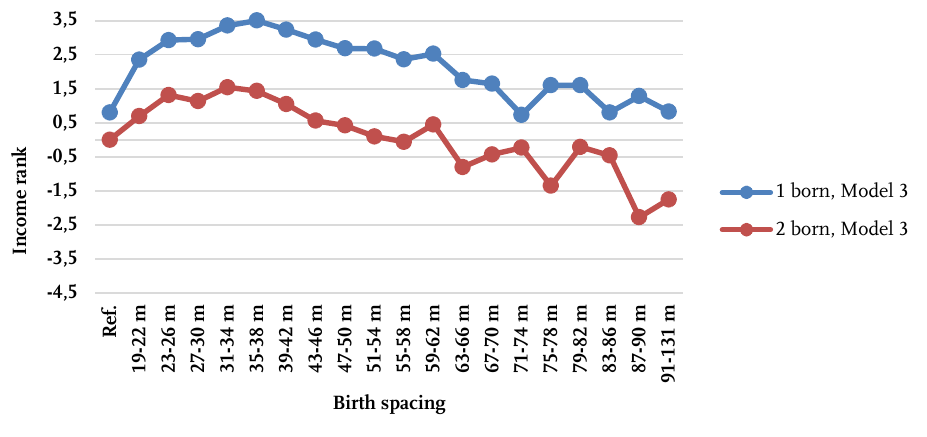
Panel A: Estimates from model 3, interaction terms